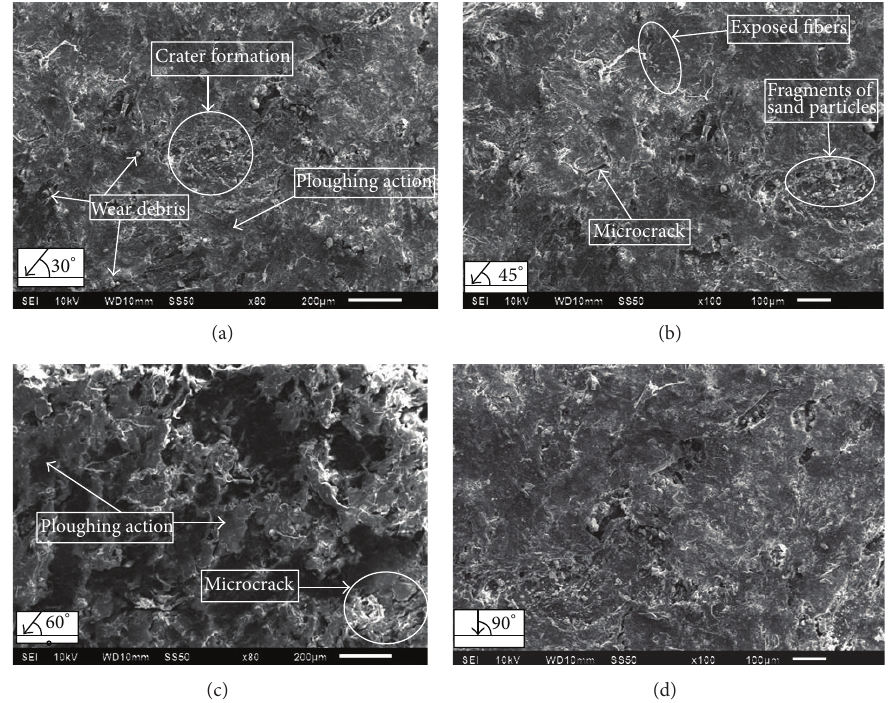
Figure 7: SEM micrographs of the eroded surfaces of 28 wt% of PVA/DPL